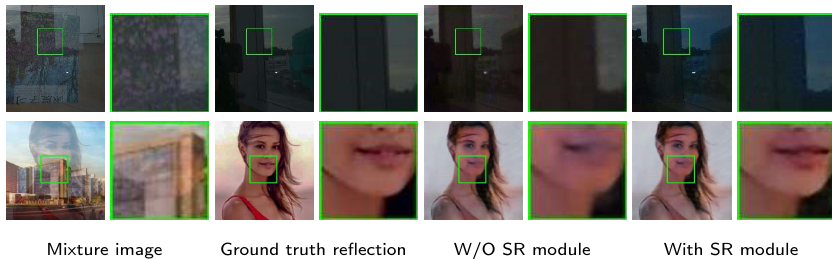
Figure 12. Comparisons of visual effects of the proposed network with or without SR module for Ours(b). The green boxes are partially enlarged for a better view.